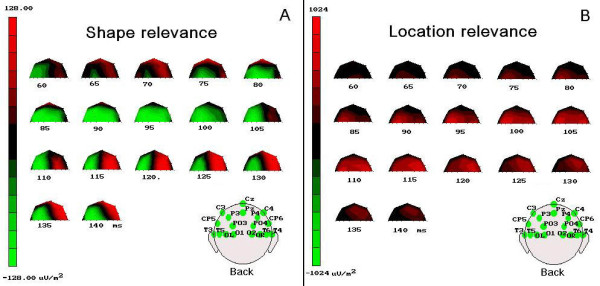
(A) Time series (pass = 5 ms) of topographical maps (back view) plotting the 3-red-black-green-colours saturation-coded surface scalp current density (SCD) values computed on the difference waveform obtained by subtracting ERPs to shape-irrelevant pairs (S-) from ERPs to shape-relevant pairs (S+), (B)Same time series maps as for A, except that SCD values were computed on the difference voltage obtained by subtracting ERPs to location-irrelevant pairs (L-) from ERPs to location-relevant pairs (L+). It is worthy of note that, overall, shape-relevance manifested as a negative SCD mostly concerning the mesial-occipital electrode sites, whereas location-relevance determined a strong positive SCD mostly concerning the lateral occipital, posterior temporal, and parietal electrode sites.